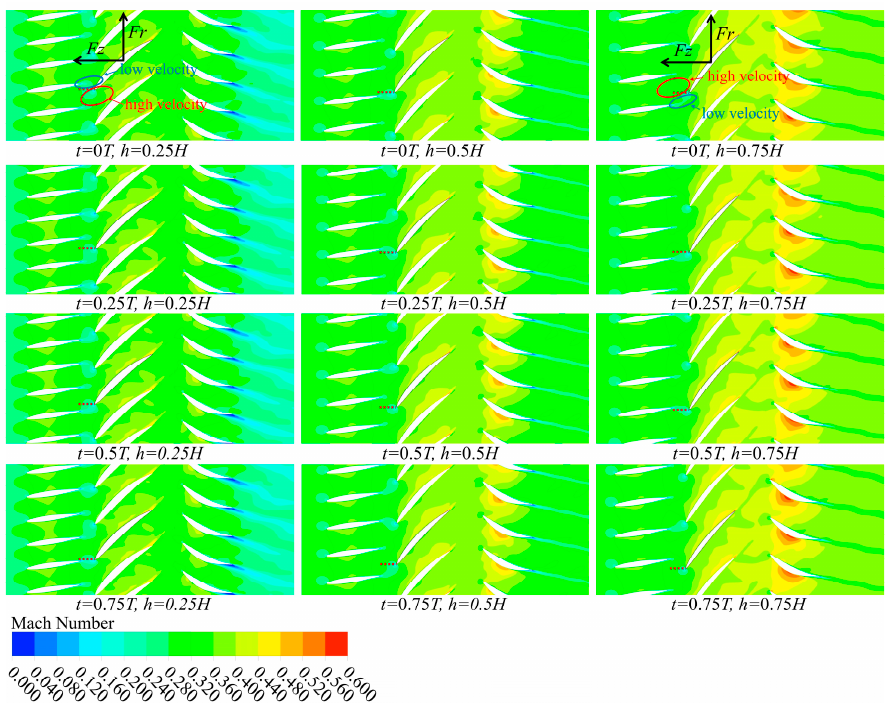
Figure 14. Mach number distribution of the 𝑎 = − 10 mm model under design conditions. The red dotted line marks the relative position of the moving vane leading edge and the guide vane. It can be seen that, at different blade heights, the relative position